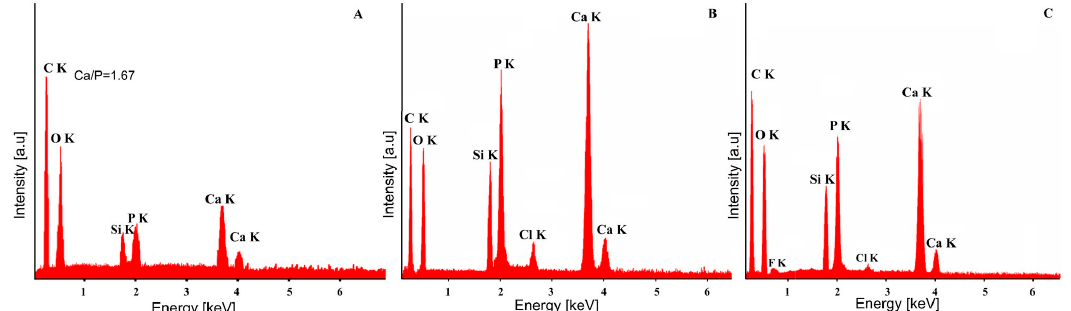
Figure 4. EDX spectra of HAp ( A ); T-HAp ( B ) and C-HAp ( C ) thin films.